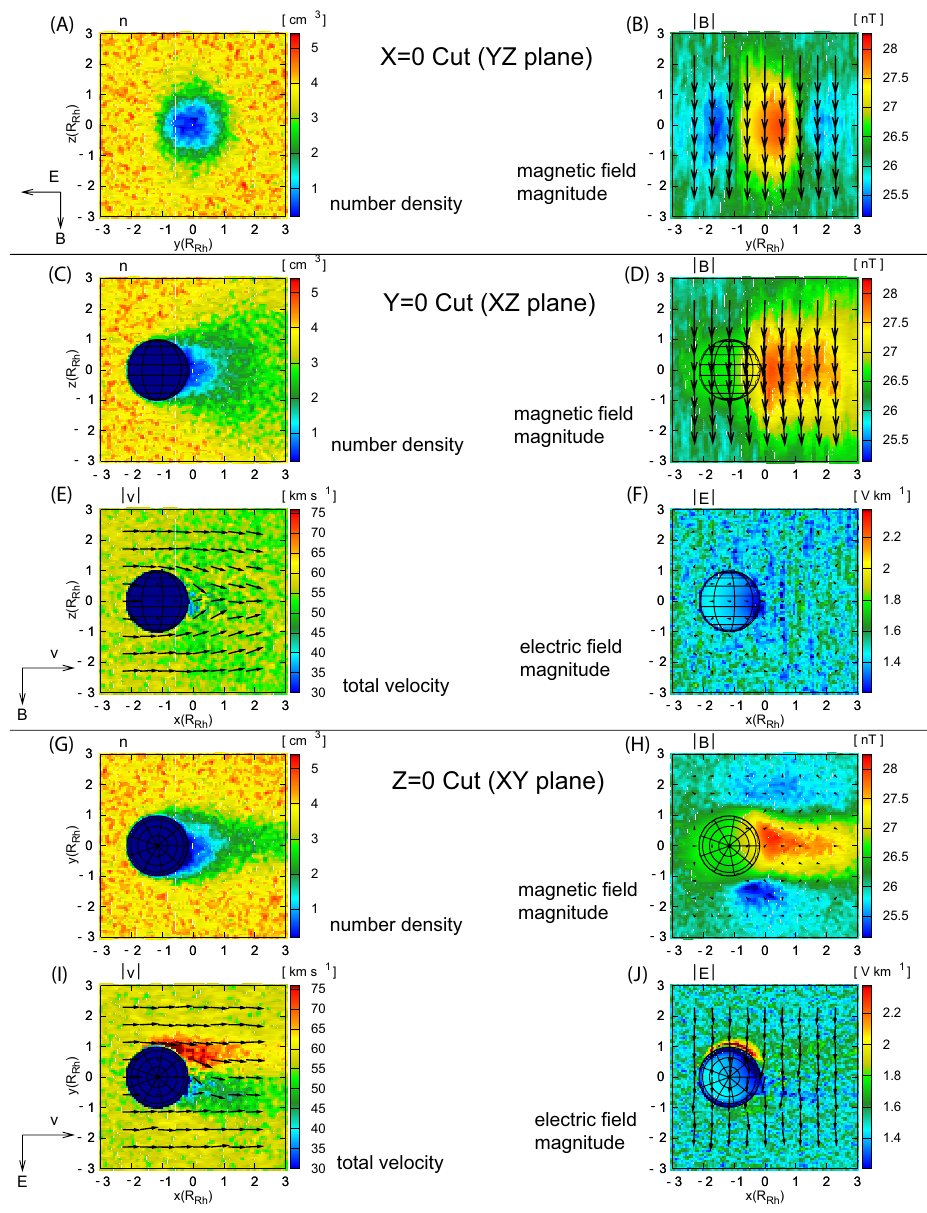
Fig. 1. Overview of results for the “ideal case” run. Different parameters are plotted, at three different cuts through the simulation box. The top panel ( x =0 cut/letters A , B ) contains the plasma density and magnetic field just behind Rhea. The second panel ( y =0 cut/letters C to F ) shows the north-south configuration of the plasma density, velocity and electromagnetic fields, while the last panel of plots ( z =0 cut/letters G to J ) includes the same parameters, projected on Rhea’s equatorial plane. In all panels, a small part of the simulation box is not shown, as it contains uninteresting regions (e.g. far upstream of Rhea). We also note that all vector parameters are plotted in the rest frame of Rhea. In several cases, perturbations in the vector quantities are small and the vectors seem unchanged compared to the background vector value and orientation (e.g. panel C). In this case, the perturbation is mainly ralized in the color coded vector magnitude. Additional plots in the plasma rest frame or with the background magnetic field subtracted, which reveal small perturbations better, are shown in Sect.